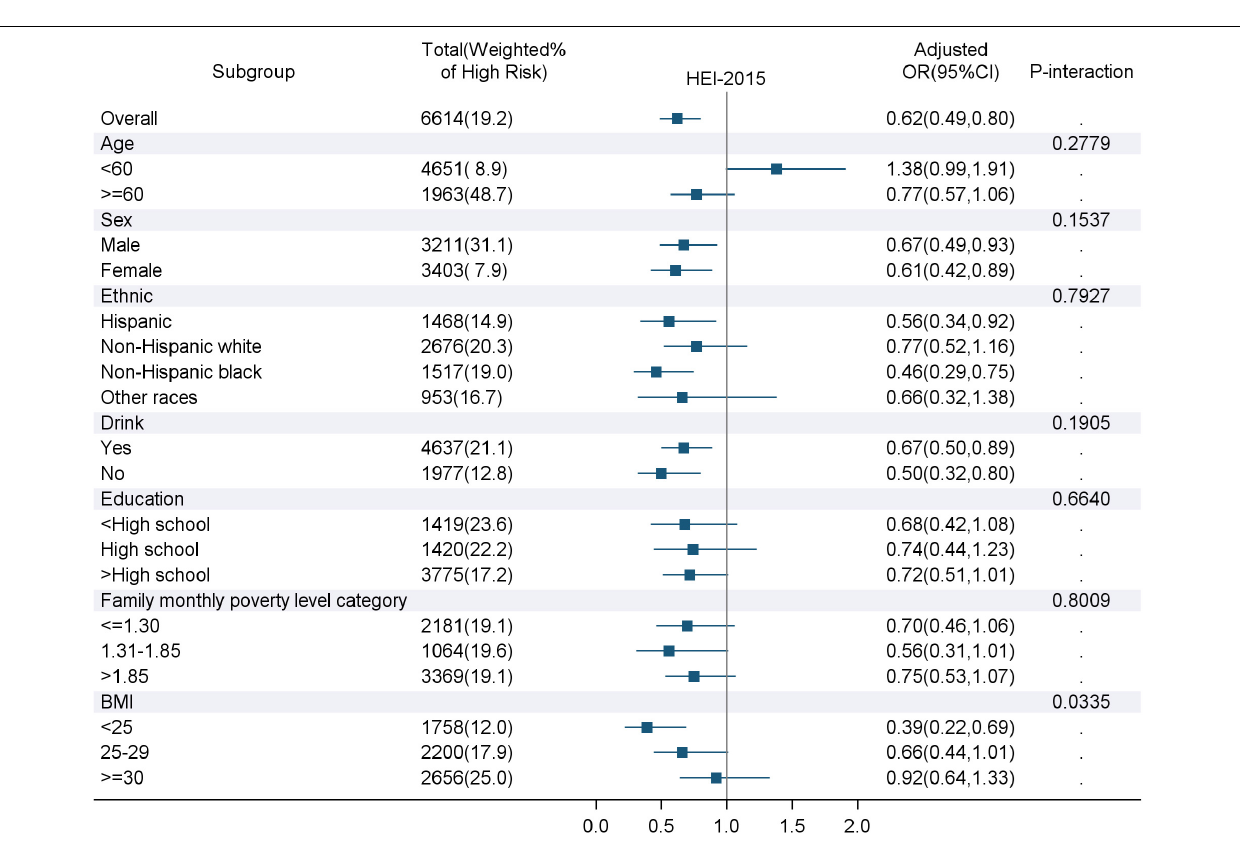
FIGURE 2 | Associations of the highest quartile of HEI-2015 score with high predicted 10-year CVD risk for subgroups. HEI-2015, Healthy Eating Index-2015; BMI, Body Mass Index; OR, odds ratio; CI, confidence interval. The variables adjusted for in the subgroup analysis were consistent with Model 3 in Table 3 , except for the subgroup variables that were not included in the model. P-interaction refers to the interaction analysis between HEI-2015 and various